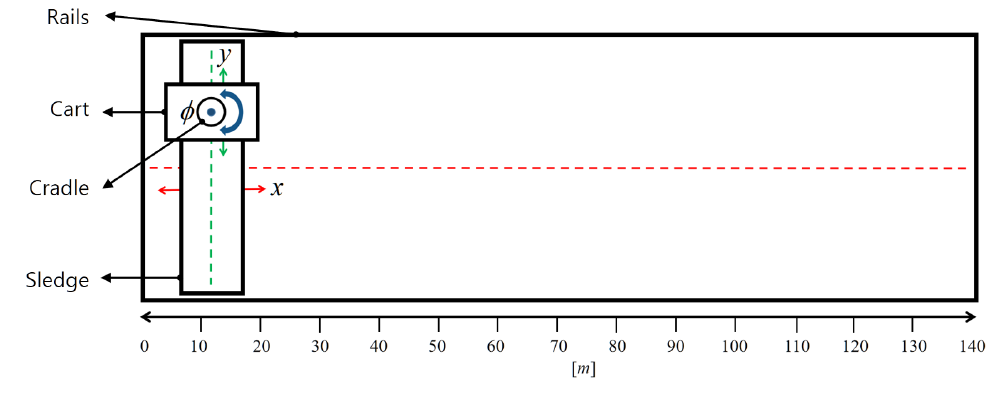
Figure 5. A schematic diagram of the ElektRail